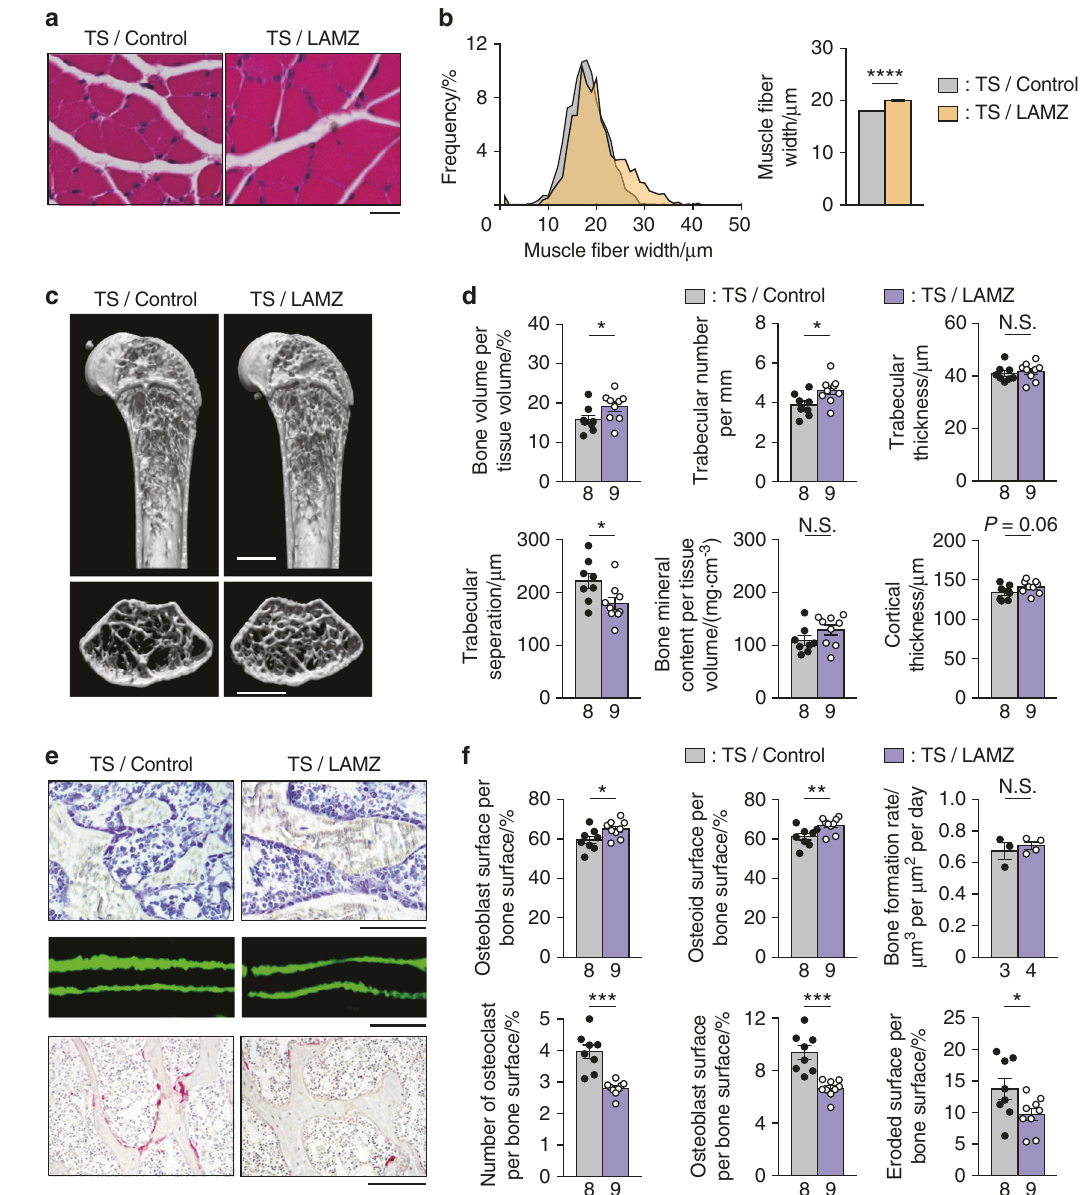
Fig. 6 Oral administration of LAMZ ameliorates the frailty of muscle and bone. a Representative histological images of the soleus muscle of tail suspension (TS) model mice orally treated with LAMZ or a control emulsion. Cross sections of the muscle were stained with hematoxylin and eosin. Scale bar, 20 μ m. b The distribution and mean value of the fi ber width of the soleus muscle. Four sections per mouse and four mice in each group were analyzed. In total, the numbers of fi bers measured were 1963 and 1530. c Representative microcomputed tomography (CT) images of the femur of the disuse model mice orally treated with LAMZ or the control emulsion. Upper, sagittal section; and lower, transverse section of the metaphyseal area. Scale bar, 1 mm. d Bone parameters obtained by micro-CT analyses. e Bone morphometric analysis of the proximal tibia of the mice orally treated with LAMZ or a control emulsion. Upper, toluidine blue staining (scale bar, 100 μ m); middle, calcein labeling (scale bar, 20 μ m); and lower, tartrate – resistant acid phosphatase (TRAP) staining (scale bar, 100 μ m). f Parameters of osteoblastic bone formation and osteoclastic bone resorption. Statistical analyses were carried out using Student ’ s t test or Welch ’ s t test. The number of biological replicates is described below each bar. The error bars show the mean ± s.e.m. * P < 0.05; ** P < 0.01; *** P < 0.001; **** P < 0.000 1; N.S. not signi fi